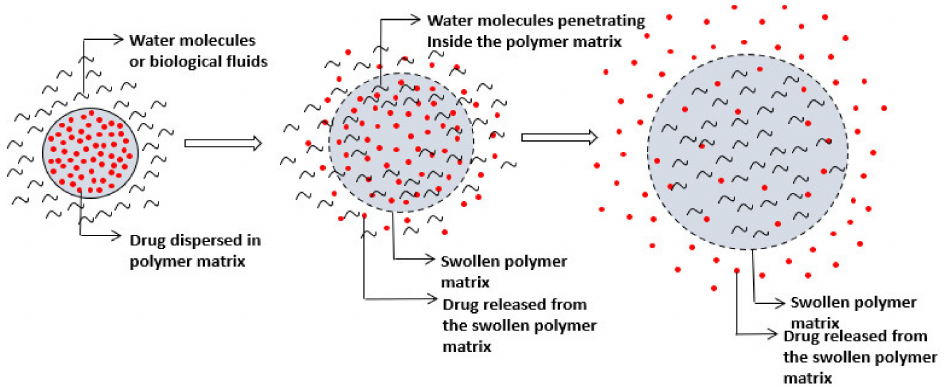
Figure 29. Schematic of mechanism of drug release from the swelling-controlled drug delivery systems.